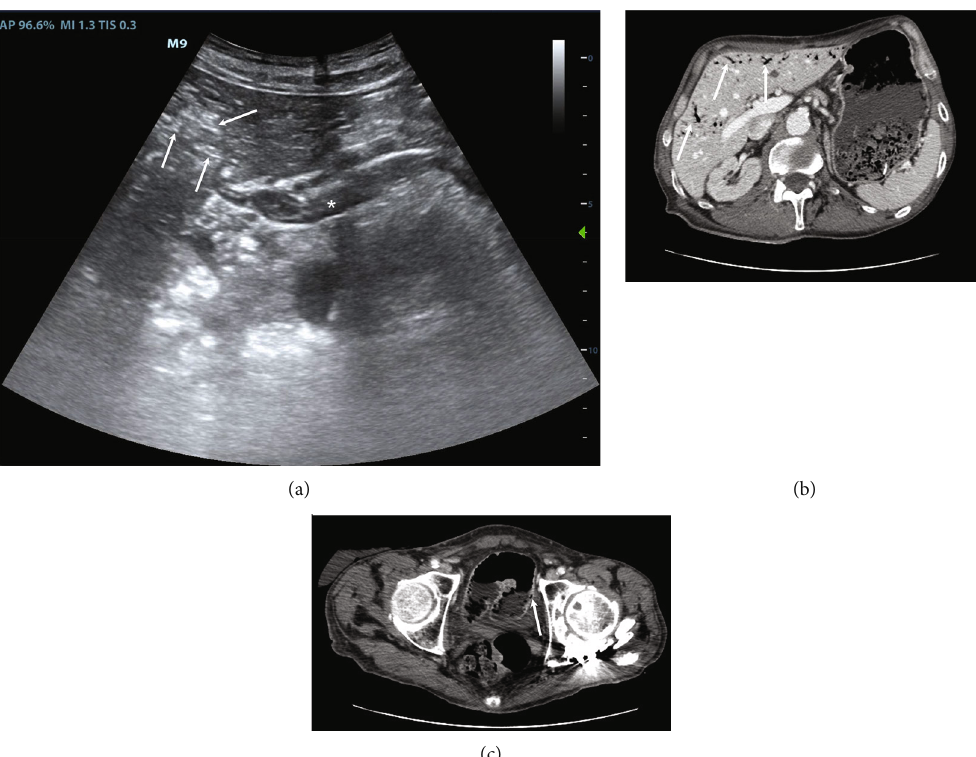
Figure 1: POCUS and CTA of case 1. (a) POCUS shows portal vein at hepatic hilum (asterisk) with multiple hyperechogenic spots into the lumen. White arrows indicate air in intrahepatic portal vessels with altered liver ultrasonographic structure. (b) A CTA scan con fi rms air into the liver (white arrows), while air is not easily identi fi ed into portal vein. (c) CTA con fi rms a little area of pneumatosis intestinalis (white arrow). POCUS stands for point-of-care ultrasonography; CTA stands for computed tomographic